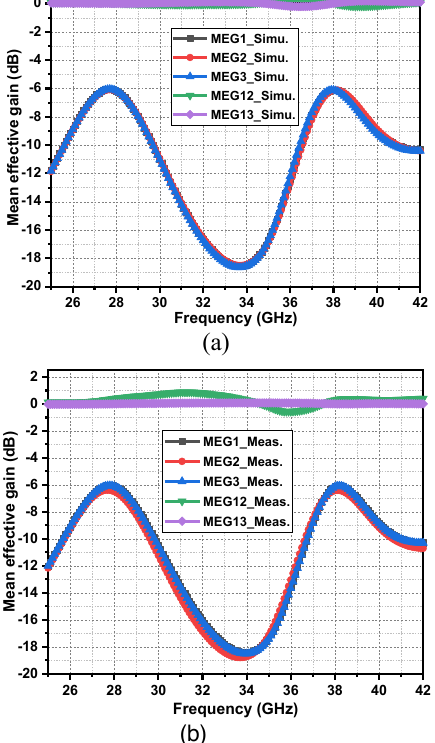
(b) FIGURE 13. The proposed MIMO antenna MEG (a) Simulated and (b) measured. EDG of the multi-antenna system provides the lower bound for diversity gain performance. Mathematically, it can be computed from the radiation efficiency and diversity gain using the relation given in equation (11) [46]. For